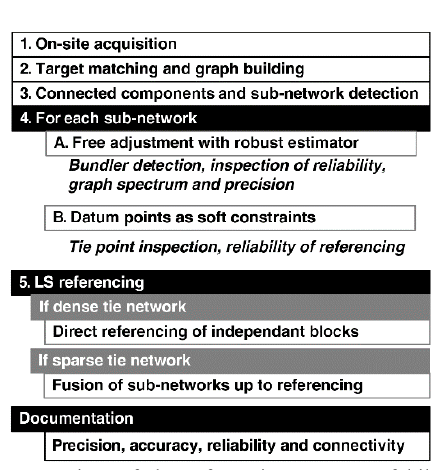
Figure 7: overview of the referencing process of kilo-station